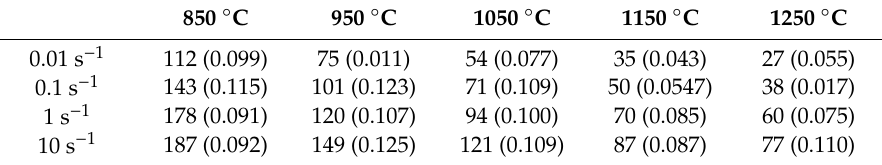
Figure 3. True stress–true strain curves for Nb-V-Ti free-cutting steel at different deformation temperatures: ( a ) 0.01 s − 1 , ( b ) 0.1 s − 1 , ( c ) 1 s − 1 , ( d ) 10 s − 1 . Table 2. Critical stress and corresponding critical strain (in brackets) for DRX initiation.